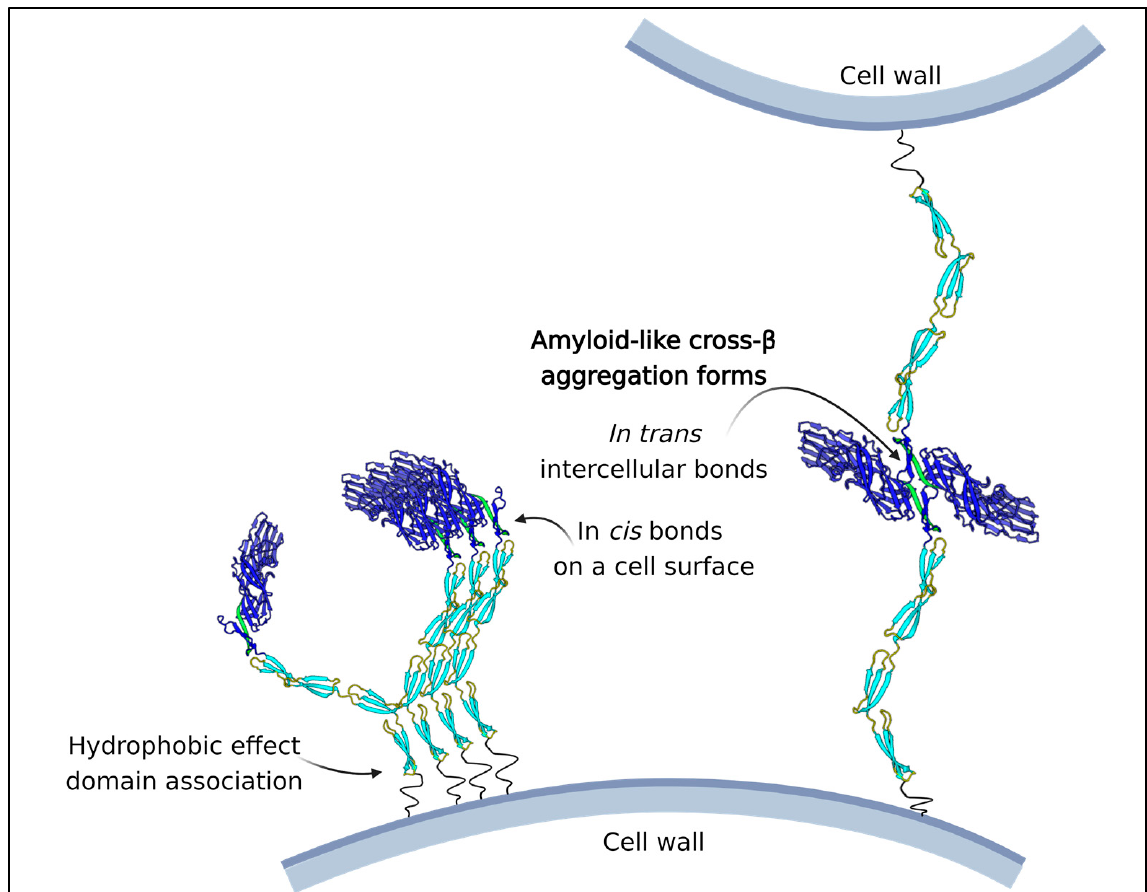
Figure 7. Roles of the amyloid core in the T region and the hydrophobic tandem repeats in aggregation of Als adhesins. The amyloid core regions (green) are exposed under low shear stress, and then form cross- β bonds between adhesins on the surface of a cell (in cis) , and between two cells (in trans ). The tandem repeats (light blue) also cluster the adhesins through hydrophobic interactions (left) [82]. The long unstructured stalk regions (black squiggle lines) add the extension and flexibility that allow these interactions to occur.